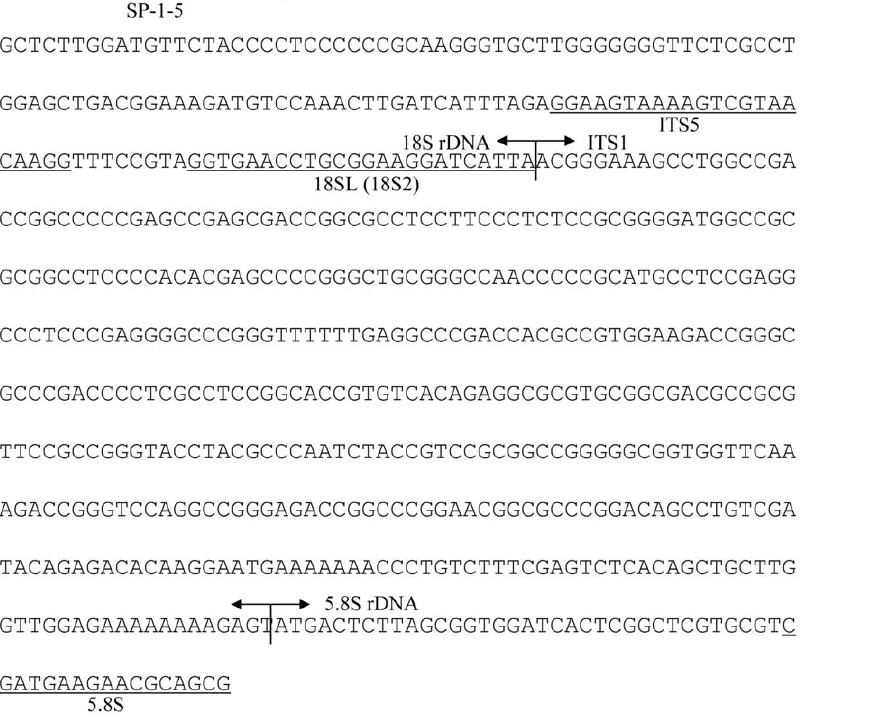
Figure 1. Nucleotide sequence of a 676 bp fragment from a common type clone (eel00-01) amplified from an adult Japanese eel ( Anguillajaponica ; eel00). This clone comprised 202 bp partial sequence of 18S rDNA, 422 bp entire sequence of ITS1, and 52 bp partial sequence of 5.8S rDNA. PCR primers are underlined.